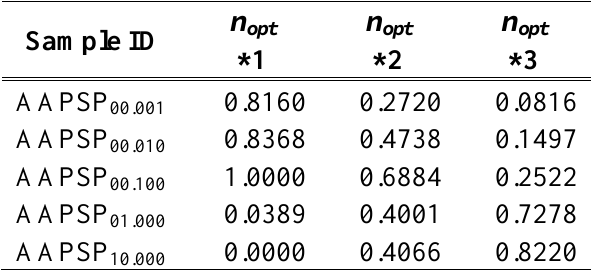
Table 3. Optimum value, n given luminophore concentration. Condition *1 :   =  =  = 1/3. Condition *3 :    